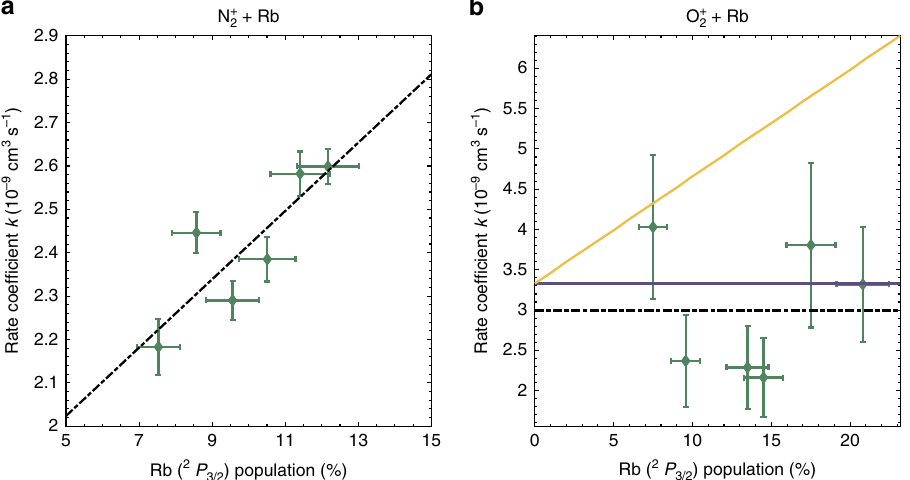
Fig. 1 Energetics of charge-transfer (CT) collisions. Asymptotic energies of the entrance and near-resonant product channels of a N þ collisions. The molecular ions can undergo CT with Rb in either its ð 5 s Þ 2 S 1 = 2 ground or ð 5 p Þ 2 P 3 = 2 excited state populated by laser cooling in a magneto- optical trap. All energies are referenced to the asymptotes of the lowest product channels connecting to the ground state of the relevant neutral molecules.